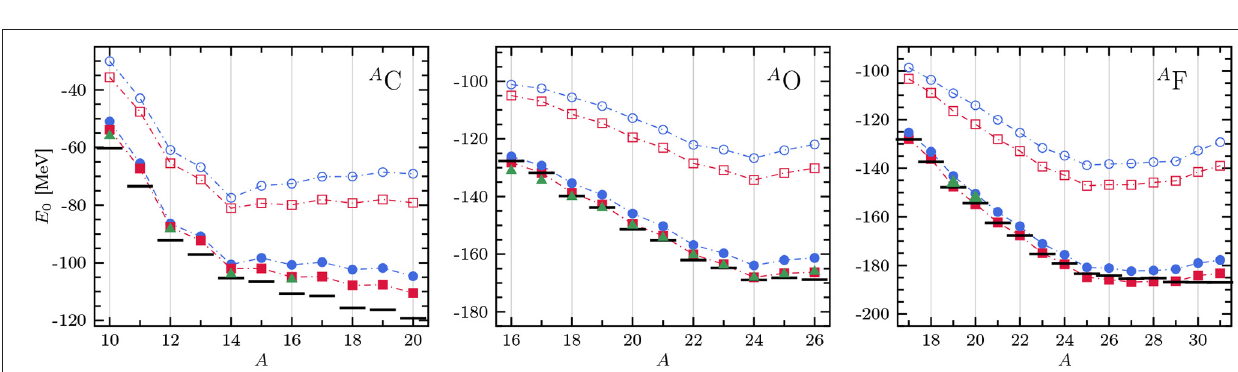
much faster convergence than absolute binding energies, thus yielding stable results in the right-hand columns of each panel. When a level re-ordering appears with increasing N max in the NCSM calculation, e.g. for the two lowest states in 12 C or the third and fourth states in 19 O, NCSM-PT reproduces the correct level ordering at small values of N ref . As for ground- max state energies, NCSM-PT results based on a reference state = 2 reproduce well the NCSM spectra, with N ref max